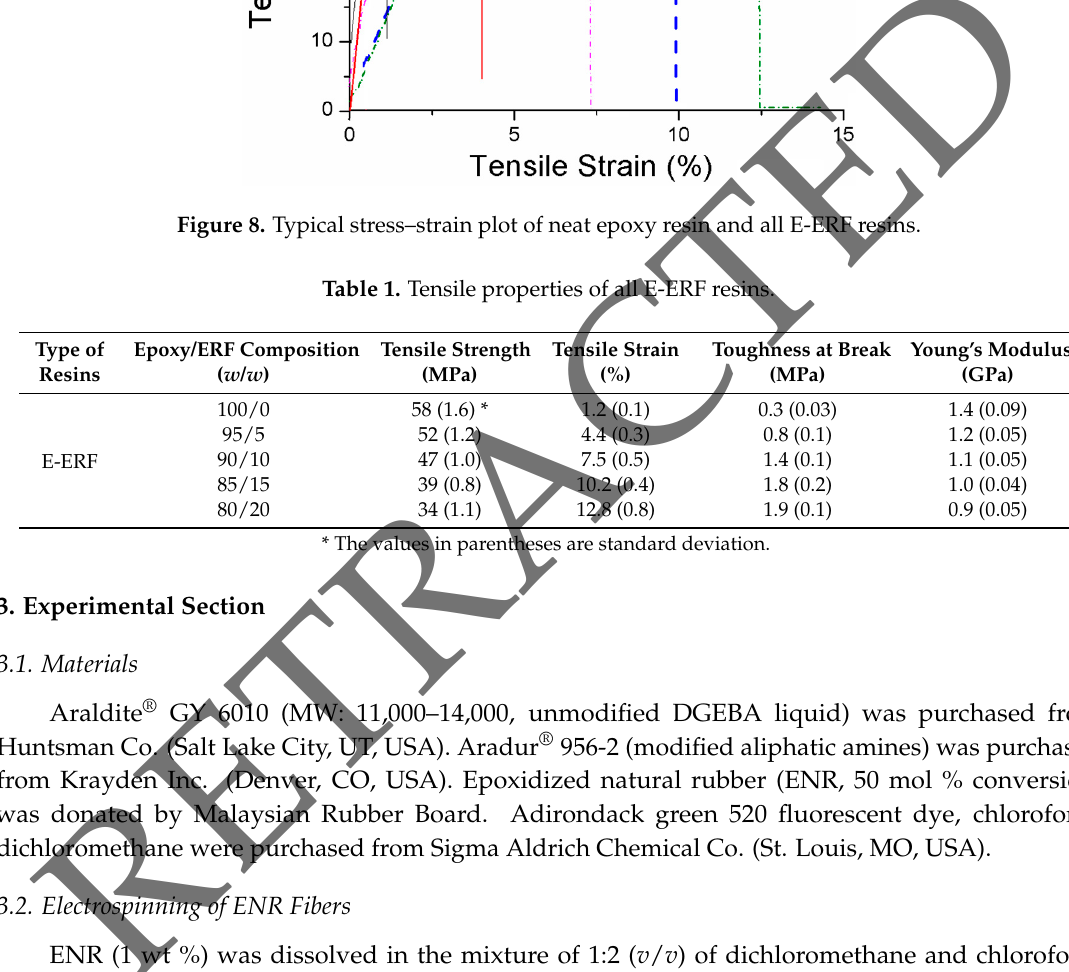
Figure 8. Typical stress–strain plot of neat epoxy resin and all E-ERF resins. Table 1. Tensile properties of all E-ERF resins.